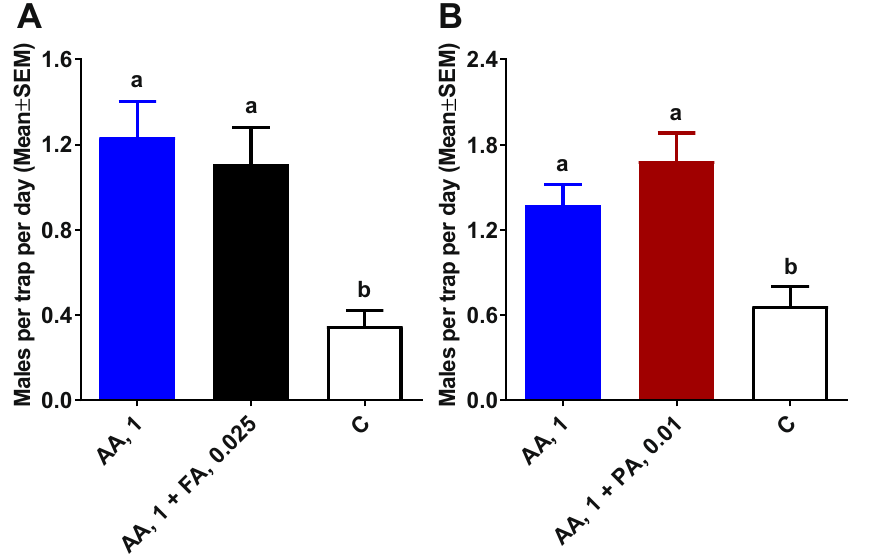
Figure 5. Field evaluations of potential synergy between attractants. Captures in traps baited with acetic acid (AA) 1 µ g were compared with catches of ACP males in traps baited with a ( A ) binary mixture of AA, 1 µ g plus formic acid (FA), 0.025 µ g or ( B ) a binary mixture of AA, 1 µ g plus propionic acid (PA), 0.01 µ g and their respective control traps. Data were analyzed by Kruskal-Wallis, followed by Dunn’s multiple comparison tests. For each test, bars labeled with the same letters are not significantly different.